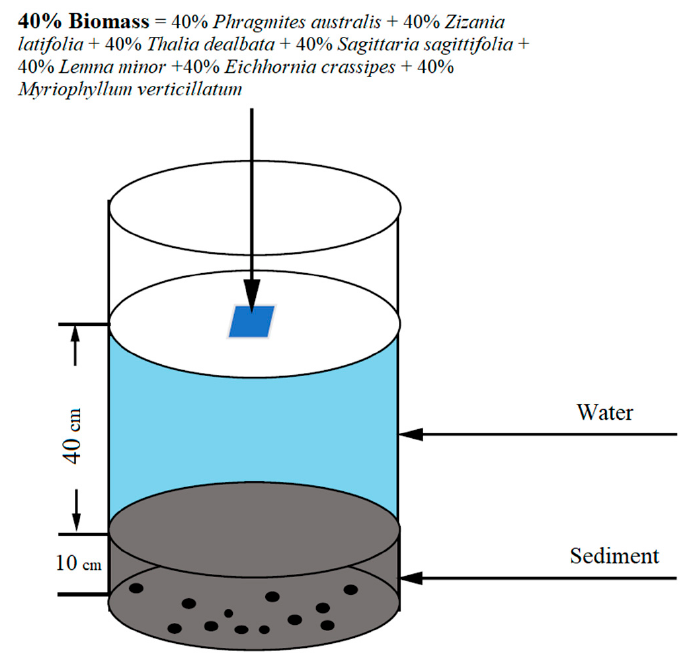
Figure 4. Amount of macrophytes used in the experiments (taking 40% biomass as an example).